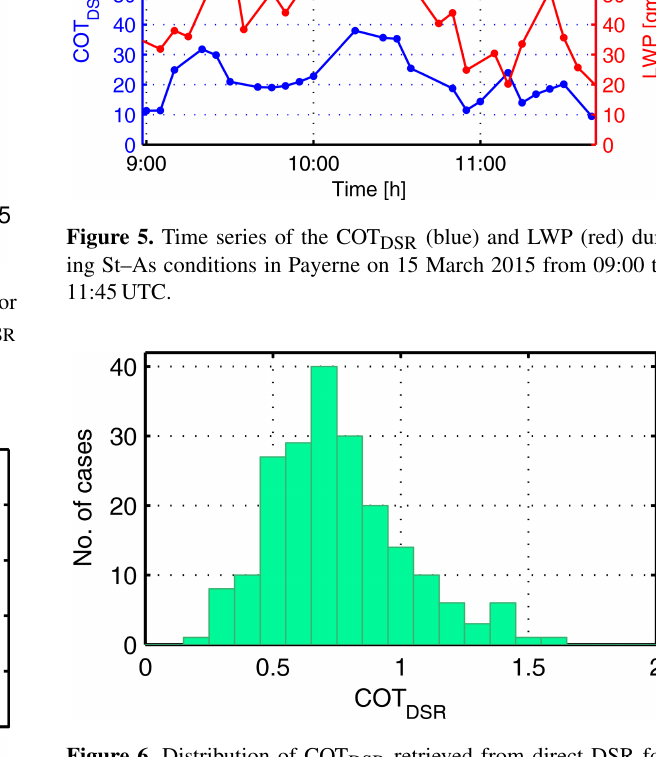
Figure 6. Distribution of COT DSR retrieved from direct DSR for cirrus–cirrostratus cases in Payerne. The mean COT DSR value is 0 . 75 ± 0 .